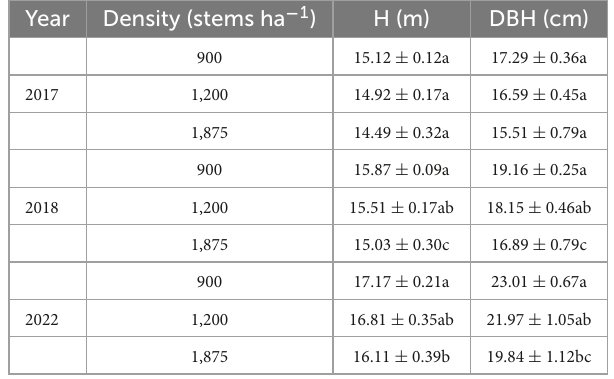
TABLE 1 Growth of Chinese fir after different thinning and interplanting treatments.